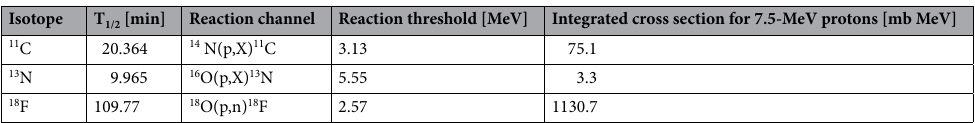
Table 1. Isotopes included in the analysis of decay curves and reaction channels responsible for tumor activation (including only allowed reactions for protons of 7.5 MeV).